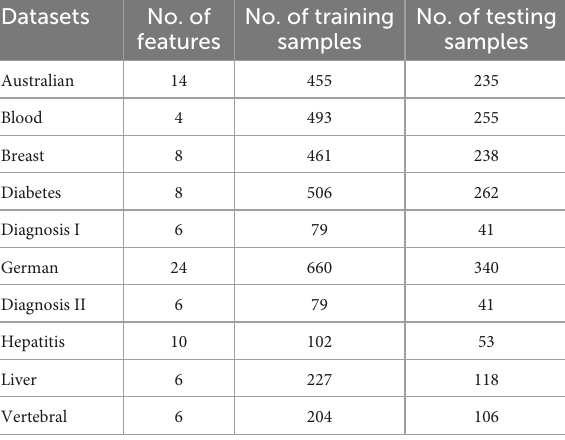
TABLE 1 Description of the classification